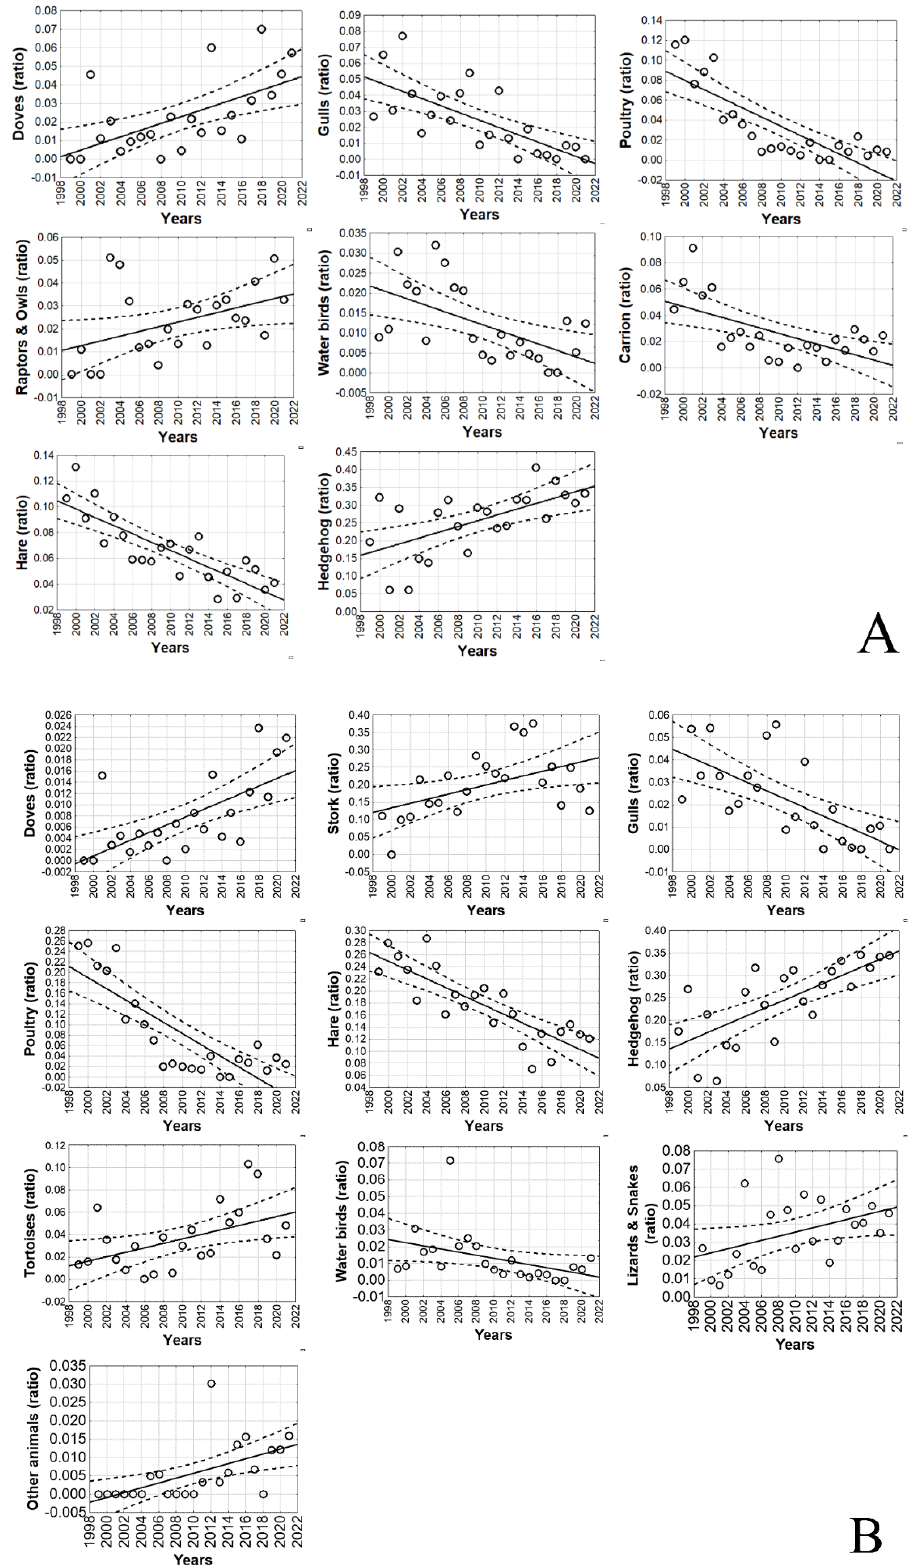
Figure 3. Results of the general linear model (GLM) showing a significant trend in frequency ( A ) and biomass ( B ) of different prey categories between 1999 and 2021.